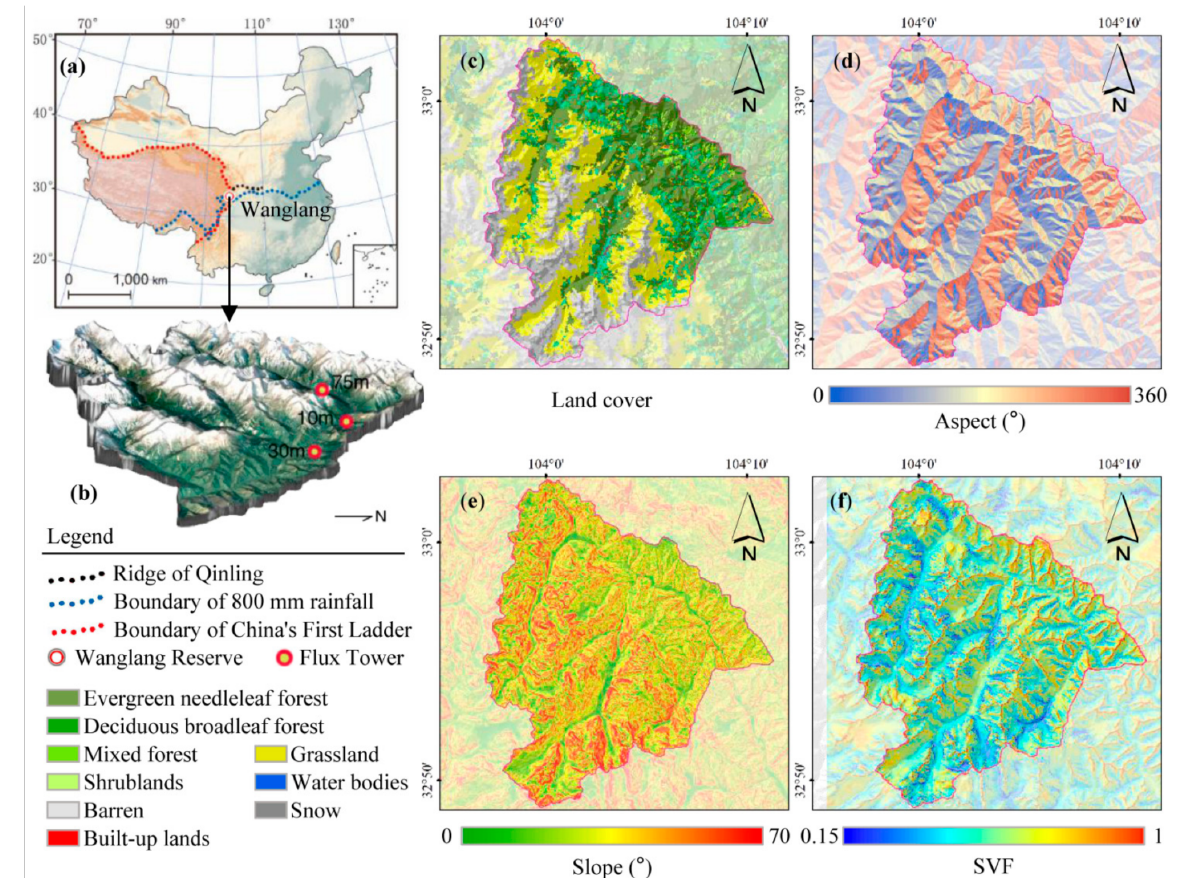
Figure 1. Spatial characteristics of elevation ( b ), land cover ( c ), aspect ( d ), slope ( e ), and SVF ( f ) over Wanglang National Nature Reserve. The location of Wanglang National Nature Reserve in China is shown in sub-figure ( a ).